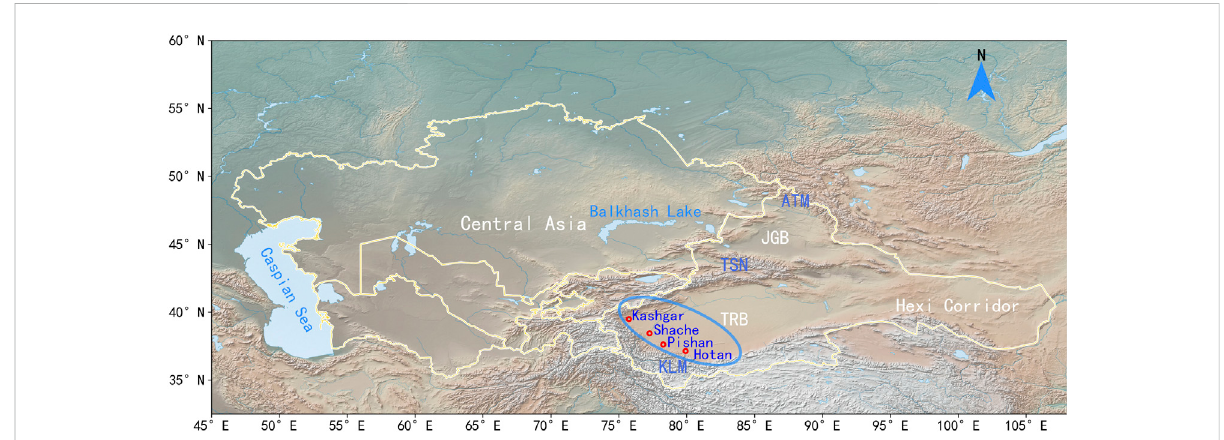
FIGURE 1 Study area, topography, and the major weather stations therein. The mountains and basins are marked as follows: Altain Mountainous (ATM), Junggar Basin (JGB), Tianshan Mountainous (TSM), Tarim Basin (TRB), and Kunlun Mountainous (KLM). The weather stations are marked with red circles and blue